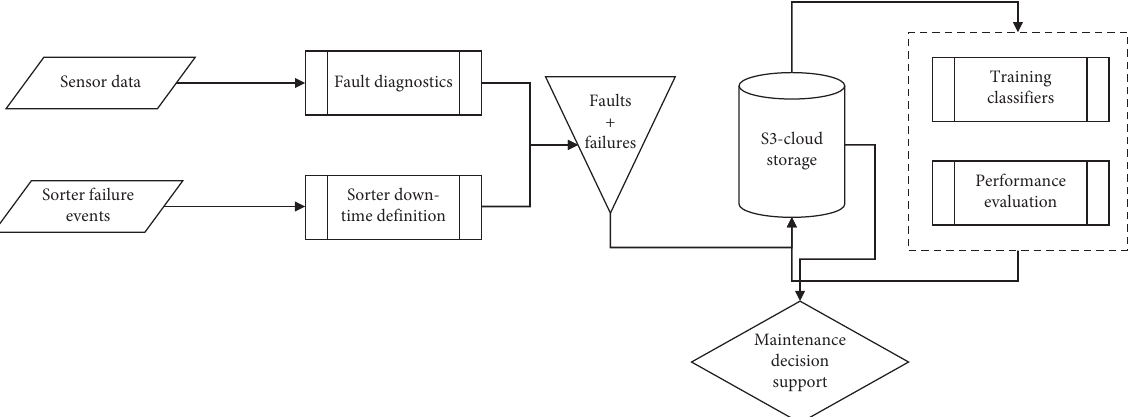
Figure 4: Machine learning architecture for fulfllment sorter equipment showing the data fow from acquisition to decision support